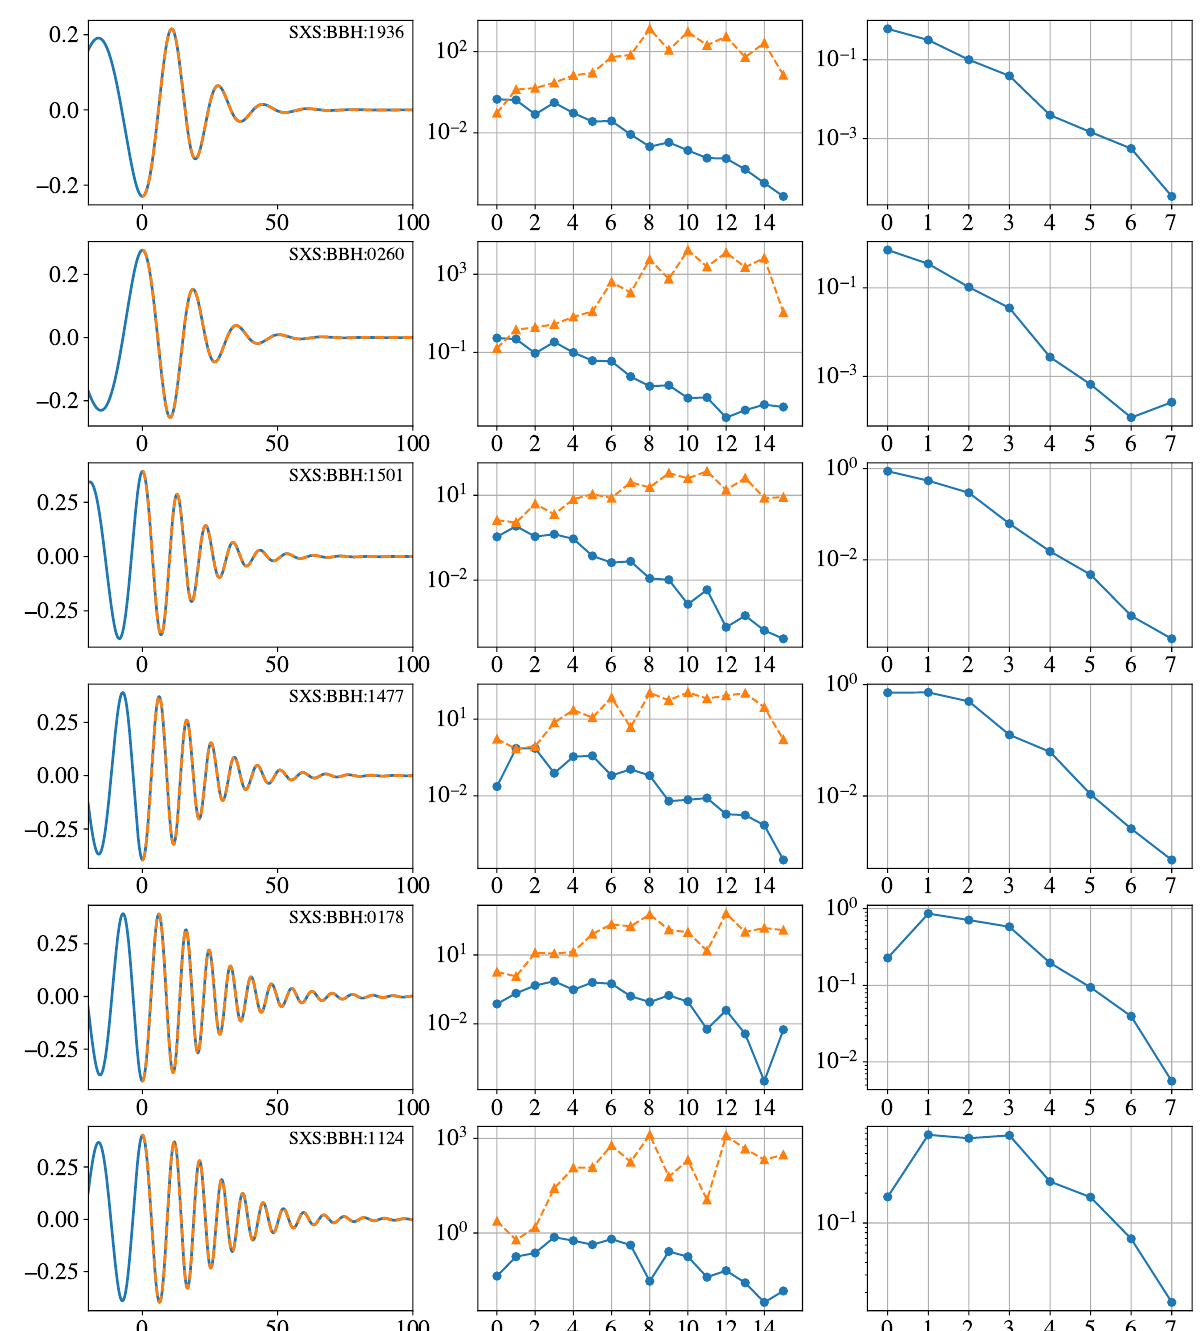
Figure A3. The waveforms and fitting coefficients of samples of SXS data listed in Table A1. The plots in the ( left column ) show the real part of ( (cid:96) = 2, m = 2 ) spheroidal harmonic mode (the blue solid line) and the QNM fit to the model with the orthonormal set given in Equation (37) (the orange dashed line). The plots in the ( center column ) present the absolute values of the fitting coefficients for ˜ C (cid:96) m (the blue filled circles) and C (cid:96) m (the orange filled triangles). The plots in the ( right k k column ) show ∆ n in Equation